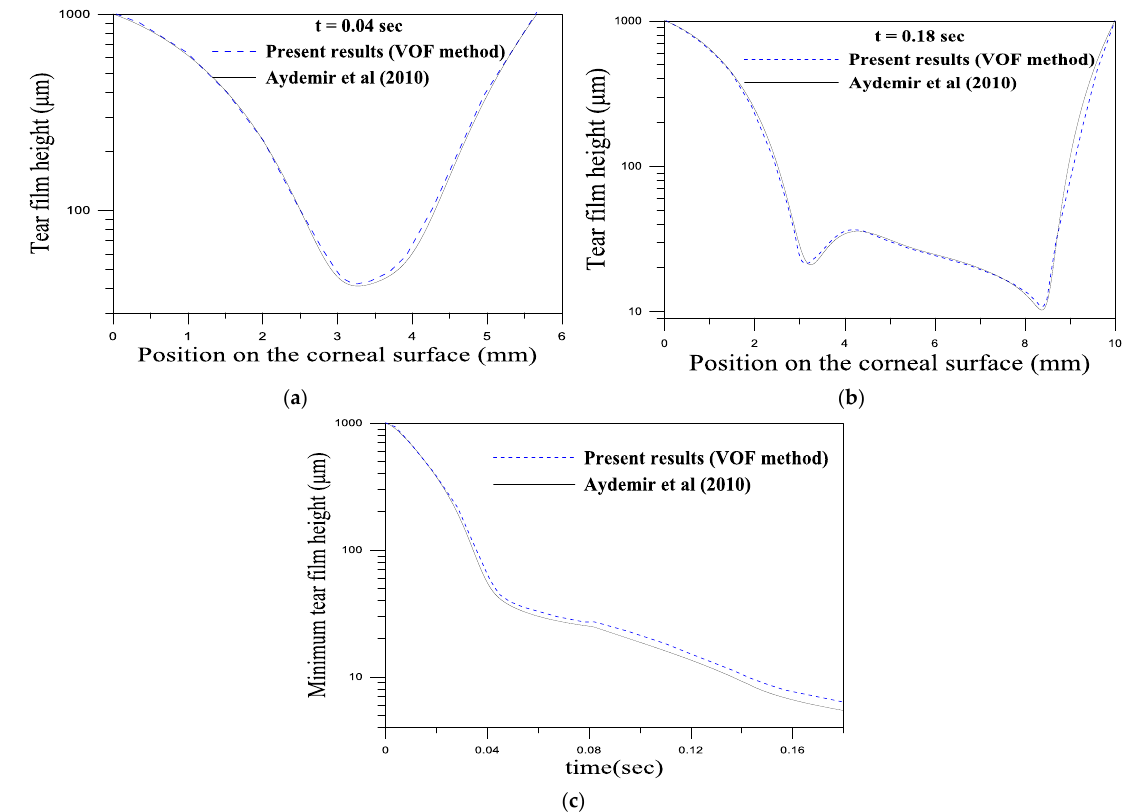
16 of 18 Figure 10. Evolution of film thickness for different mesh grids in the case of non-Newtonian film n = 0.5, k = 0.6 Pa·s and τ 0 = 1 Pa at t = 0.18 s.